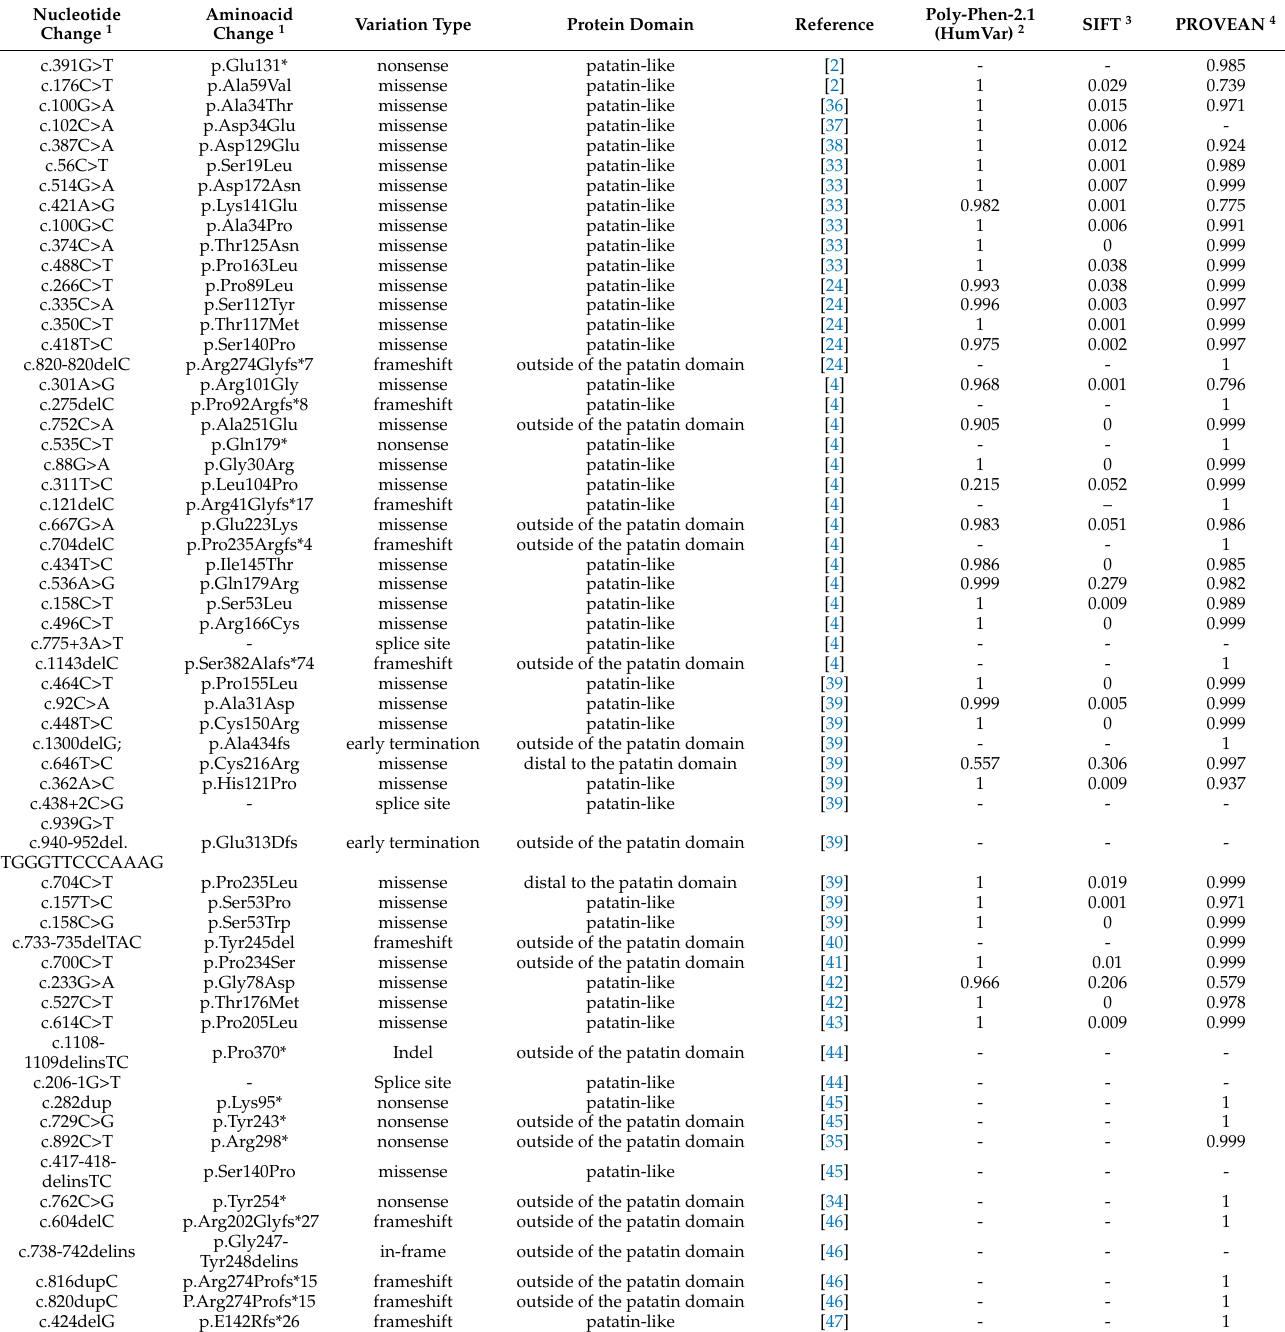
Table 1. List of human PNPLA1 gene mutations reported in ARCI